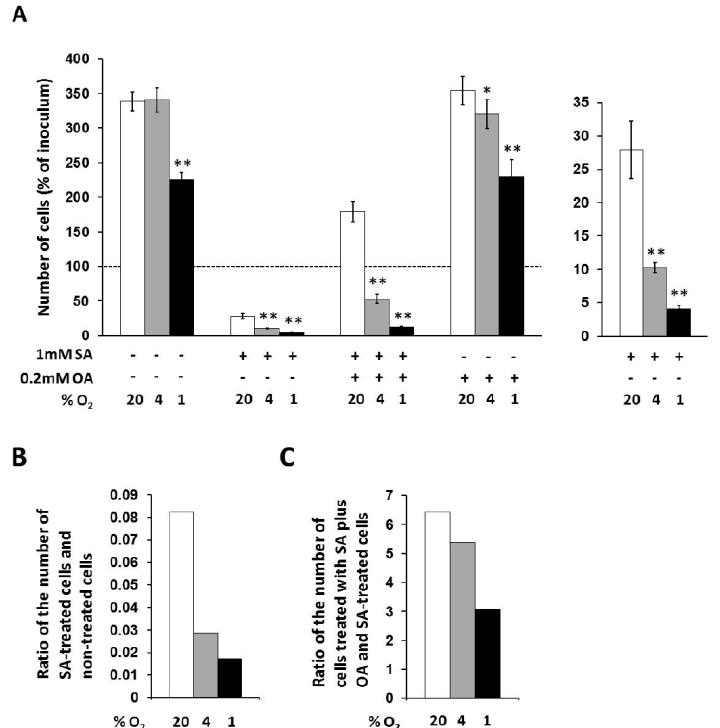
Figure 2. ( A ) Effects of hypoxia applied alone and simultaneously with 1 mM stearic acid (SA), 1 mM SA plus 0.2 mM oleic acid (OA), and 0.2 mM OA (see “Materials and Methods”) on cell